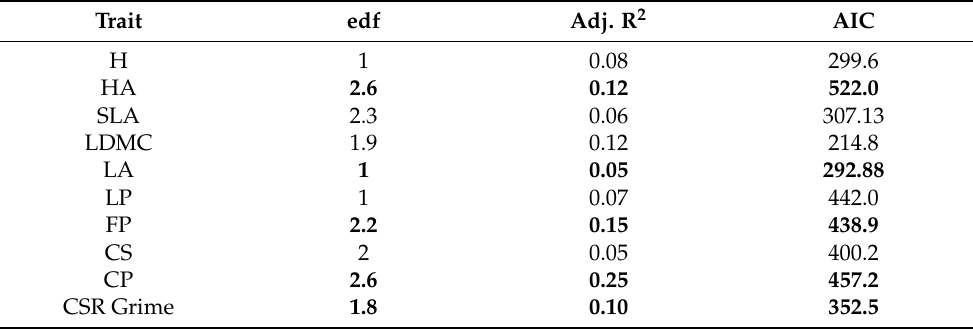
Table 2. Trends of standardized effect size of functional diversity under twice-a-year mowing of plant height (H), horizontal architecture (HA), specific leaf area (SLA), leaf dry matter content (LDMC), leaf area (LA), leaf phenology (LP), flower phenology (FP), clonal spread (CS), clonal position (CP), and Grime’s CSR strategies. Significant relations ( p -value < 0.05) are indicated in bold. AIC values are referred to REML (restricted maximum likelihood). Effective degrees of free- dom (edf) are a measure of the shape of the curves (with 1 completely linear; 2 completely quad- ratic; 3 completely cubic). Trait